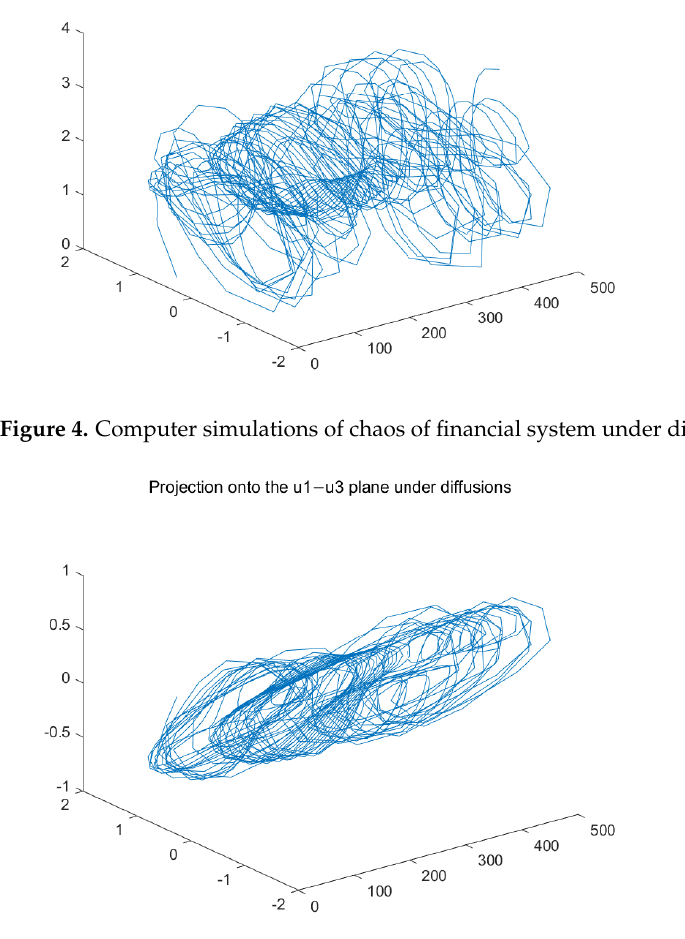
Figure 5. Computer simulations of chaos of financial system under